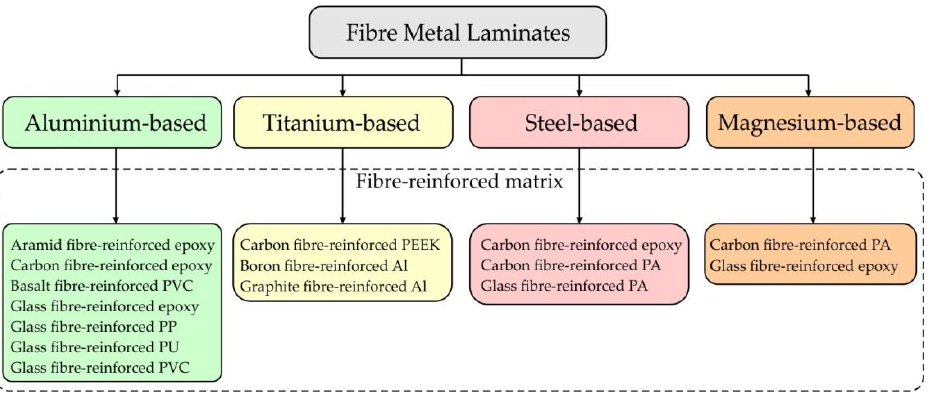
Figure 1. Classification of fibre metal laminates.